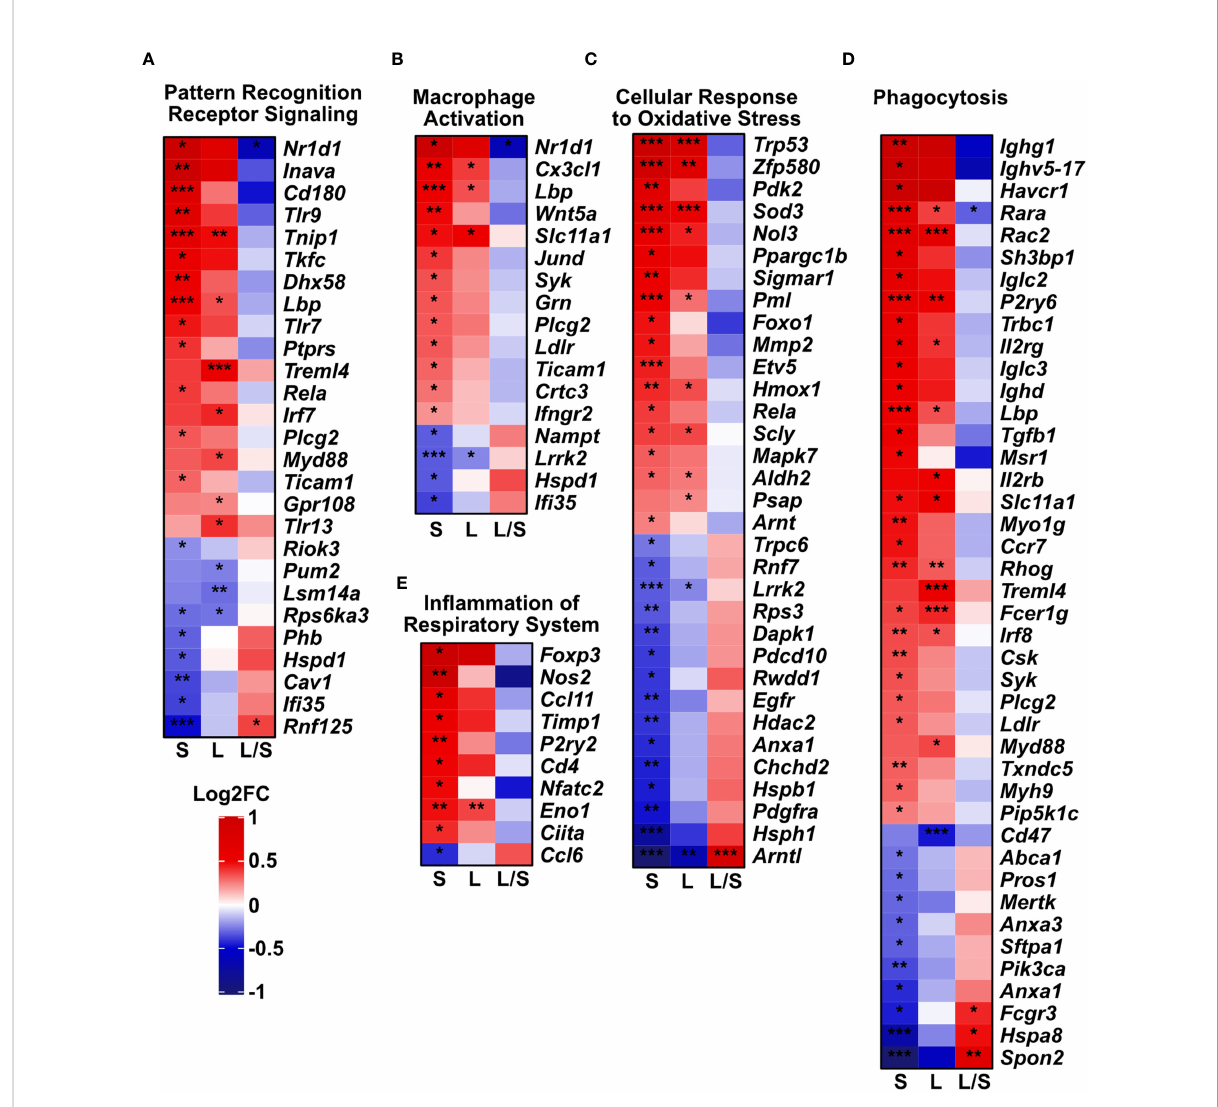
FIGURE 4 Innate immune gene clusters are differentially regulated upon mesenchymal stem cell administration. The analysis was performed based on Mouse Genome Informatics (MGI v.6.17) Gene Ontology Browser; http://www.informatics.jax.org/vocab/gene_ontology/; access 29 th June 2022). Only signi fi cant genes in either of the groups were plotted (adjusted p-value < 0.05). Heatmaps represent the changes in gene expression related to (A) Pattern Recognition Receptor Signaling Pathway (Biological Process; GO:0002221). (B) Macrophage Activation (Biological Process; GO:0042116). (C) Cellular Response to Oxidative Stress genes (Biological Process; GO:0034599). (D) Phagocytosis (with 4932438a13rik gene excluded due to unidenti fi ed biological role); (Biological Process; GO:0006909). (E) In fl ammation of Respiratory System (genes predicated by functional analysis